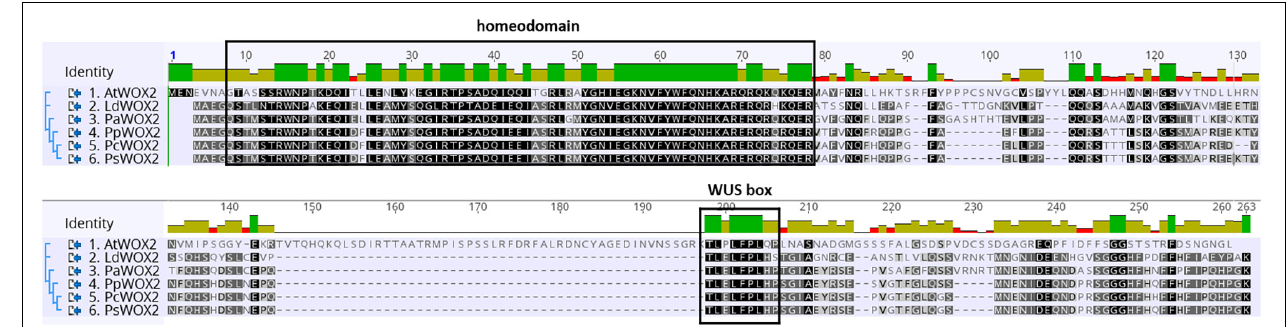
FIGURE 1 | Comparative WOX2 amino acid sequences in the angiosperm Arabidopsis thaliana (AtWOX2) and in 5 conifers, namely, Larix decidua (LdWOX2), Picea abies (PaWOX2), Pinus pinaster (PpWOX2), Pinus contorta (PcWOX2), and Pinus sylvestris (PsWOX2). Introduced gaps in the amino acid sequences are indicated by dashes. Boxes show the putative WOX homeodomain and WUS box. Amino acid identity is shown by a color